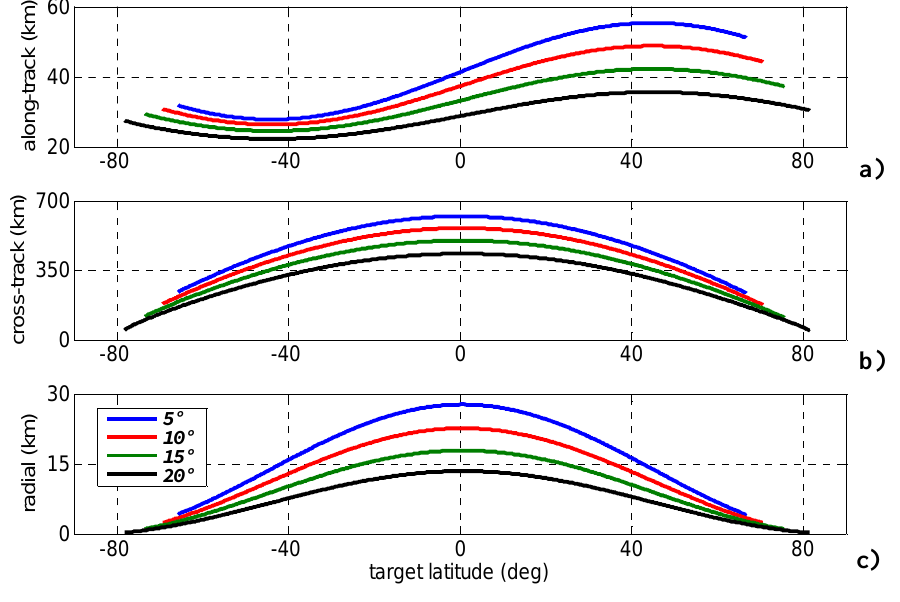
Figure 6. (a) Along-track, (b) cross-track, and (c) radial baseline components for four bistatic antenna off-nadir angles within the range of covered latitudes.